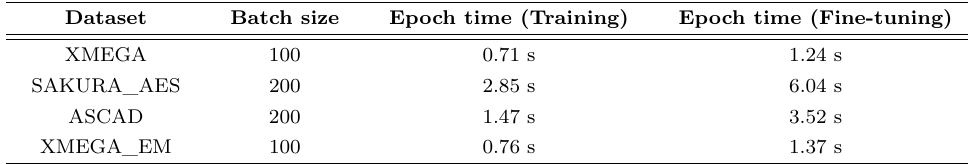
Table 3: Summary of the computation